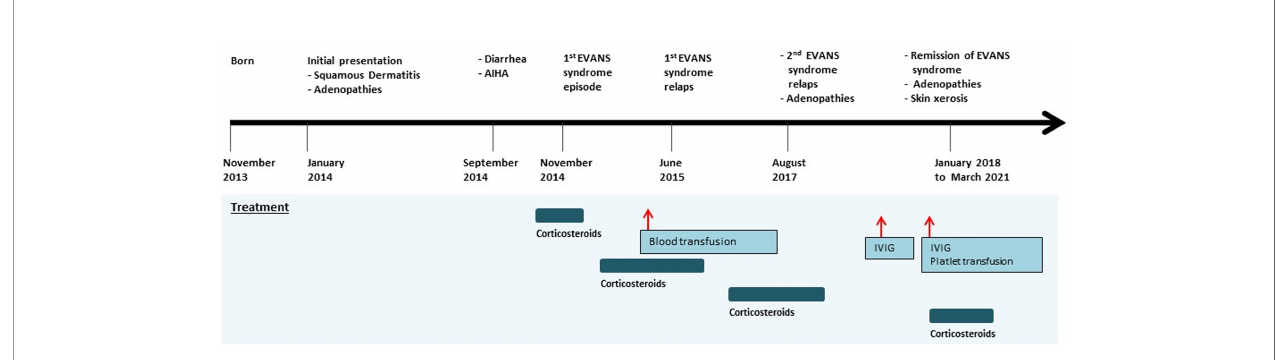
FIGURE 1 | Timeline of the clinical events and treatment strategies. AIHA, autoimmune hemolytic anemia; IVIG, intravenous